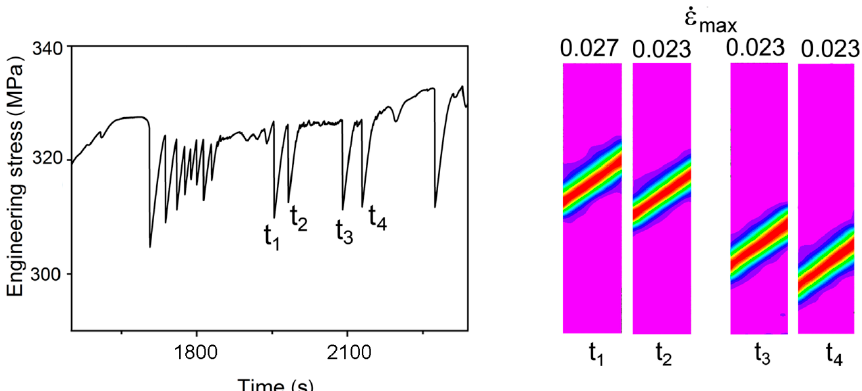
Figure 8. Initial portion of the deformation curve shown in Figure 2 and digital image correlation (DIC) images of the distribution of the local strain rate over the gauge part of the sample. The DIC images are recorded at the instants indicated on the deformation curve. The maximum value of the local strain rate within the band is indicated at the top of each snapshot.